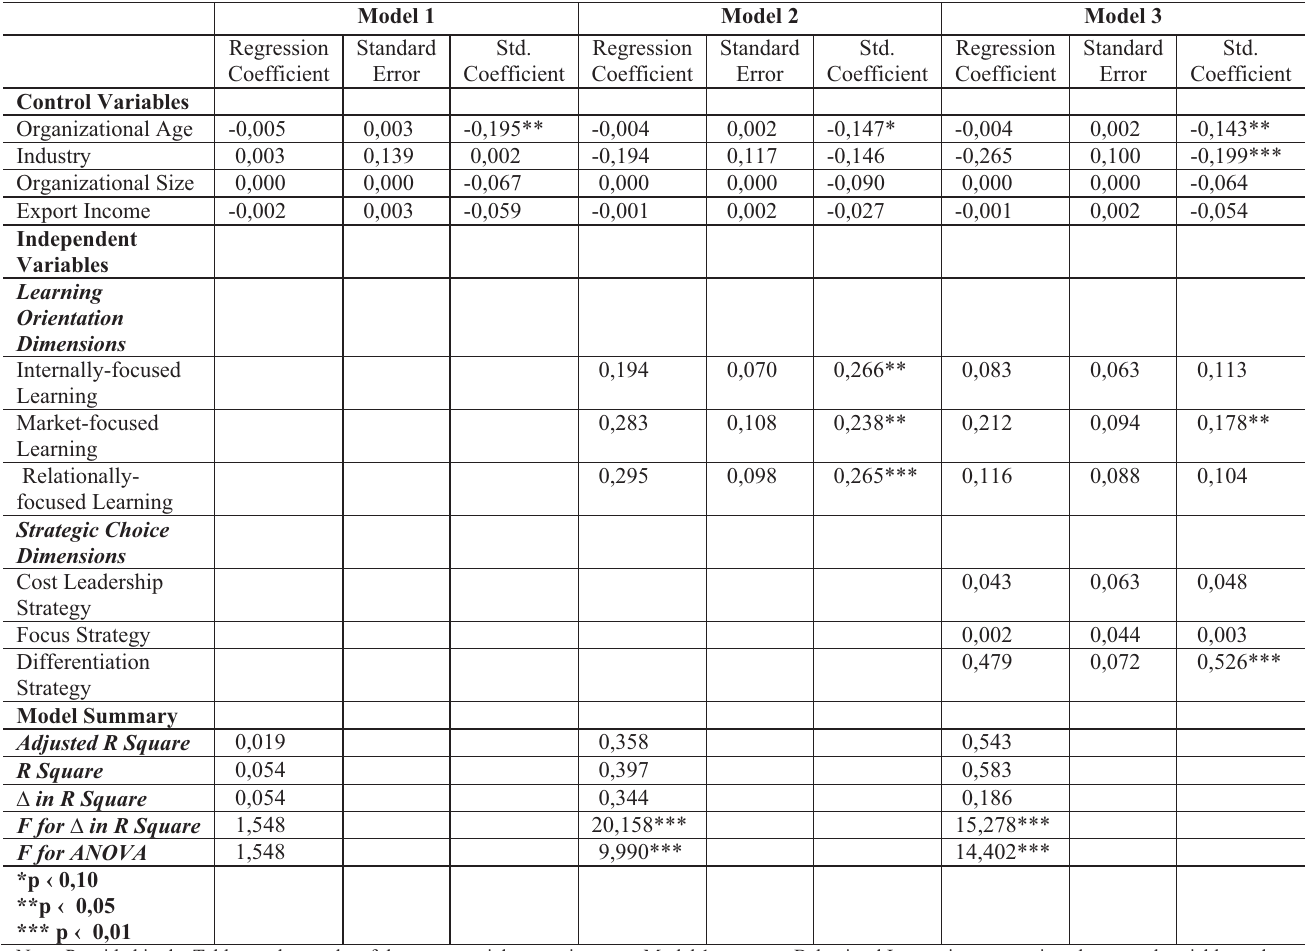
Table 3: Regression results for behavioral innovativeness Model